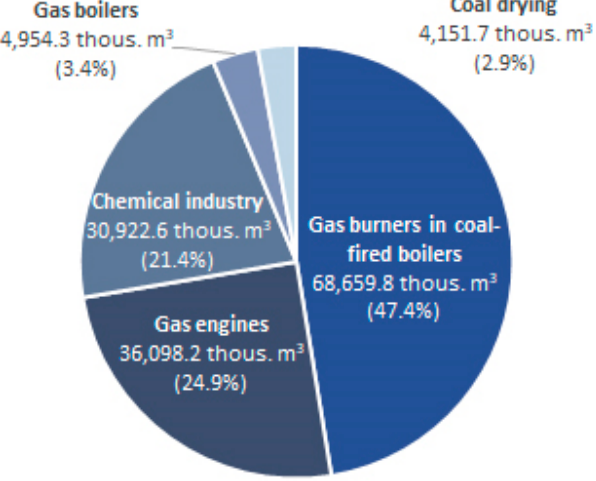
Figure 3. Use of drained methane in Polish coal mines.